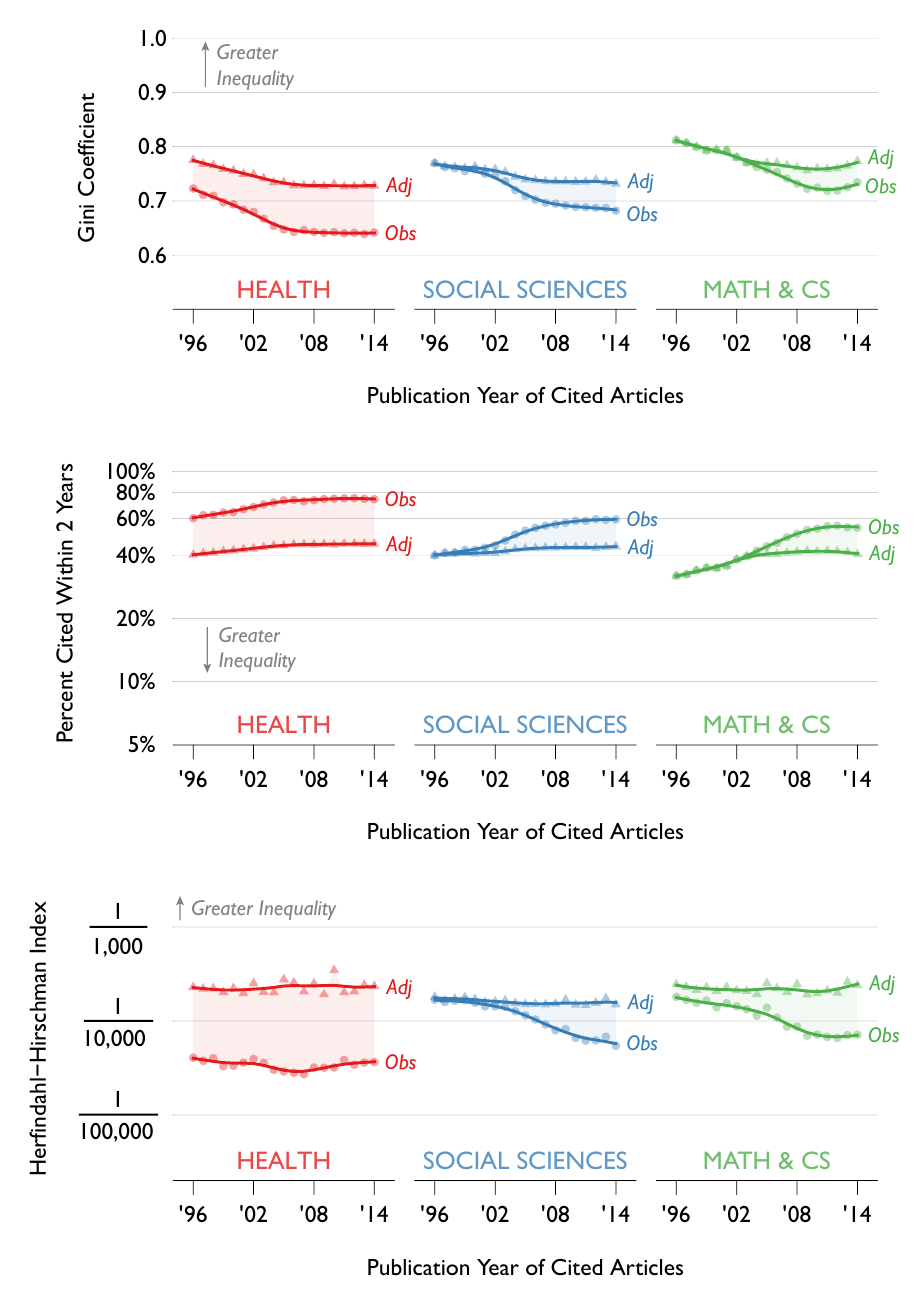
Figure 8: Gini coefficient, percentage of articles with any citations, and Herfindahl-Hirschman Index